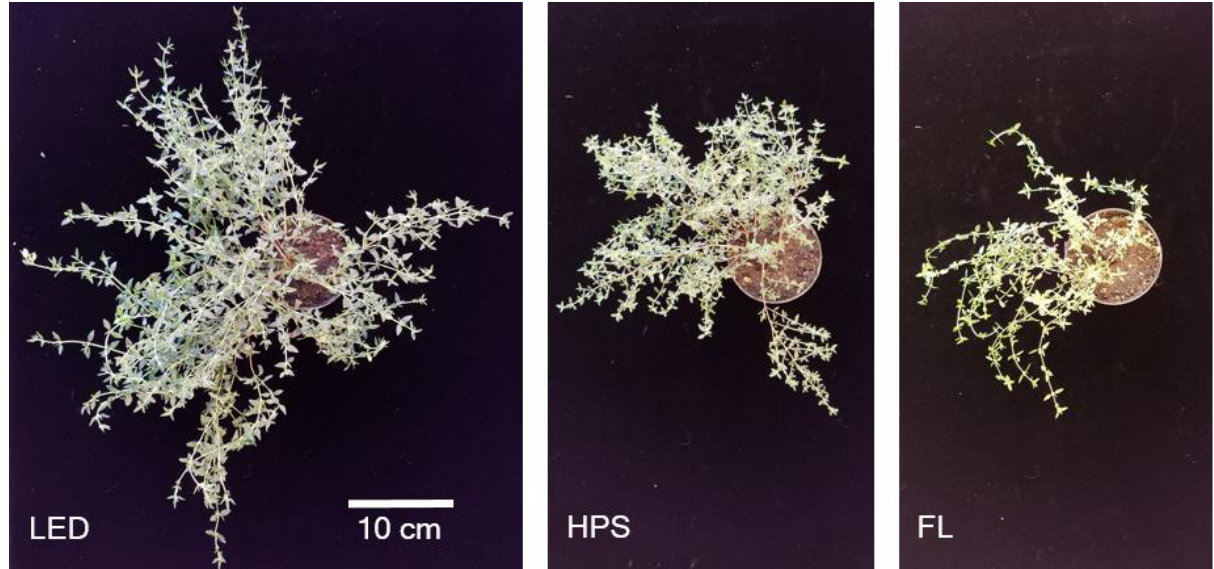
Figure 2. Visual appearance of Thymus vulgaris L. at harvest cultivated under different supplemental lighting systems during fall and winter of Berlin, Germany. LED = light-emitting diode, HPS = high-pressure sodium lamp, FL = fluorescent light.